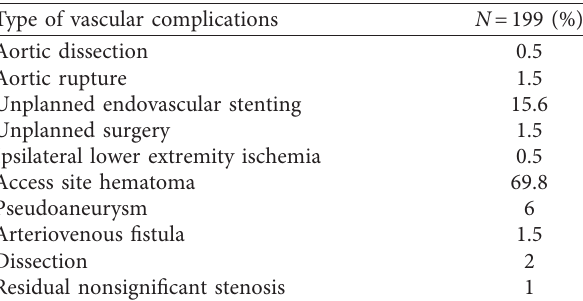
Table 3: Description of the observed vascular complications. Type of vascular